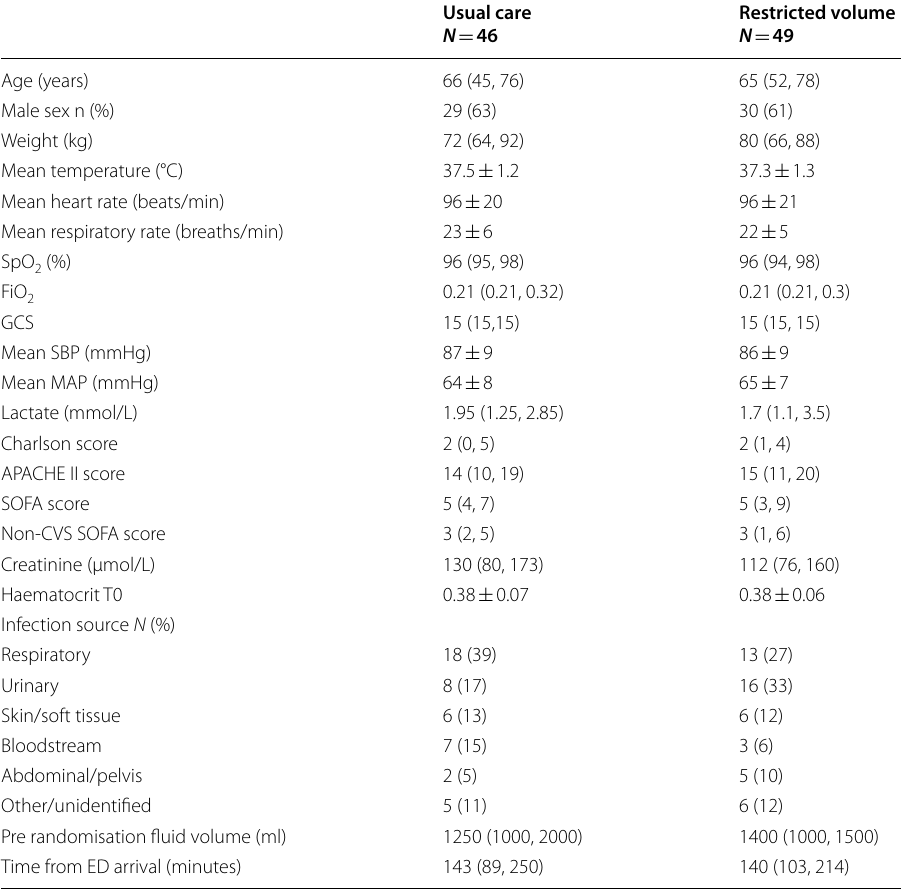
Data are medians (Q1, Q3) unless stated otherwise. SBP systolic blood pressure, SpO 2 peripheral oxygen saturations, FiO 2 fractional inspired oxygen concentration, GCS Glasgow Coma Scale, APACHE Acute Physiology and Chronic Health Evaluation, SOFA Sequential Organ Failure Assessment, Non-CVS SOFA total SOFA score minus cardiovascular domain